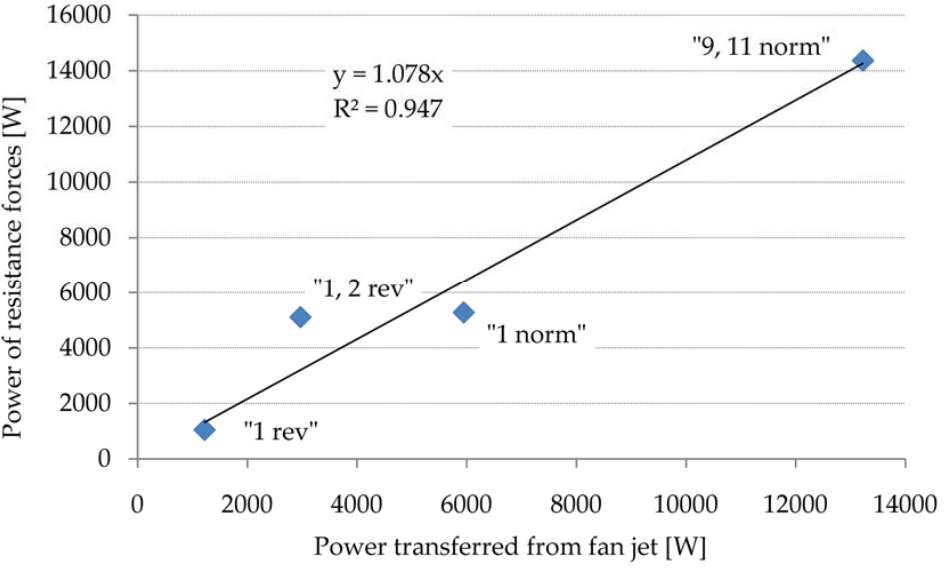
Figure 5. Linear regression Δ E kT = P R .